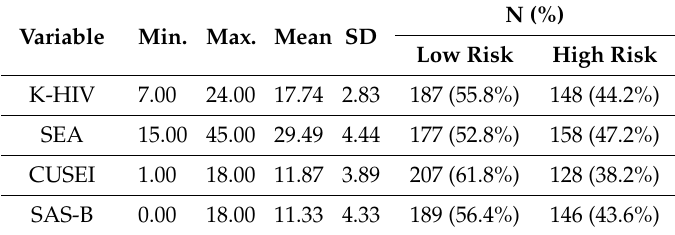
Table 2. Scores in dimensions of risk of HIV infection in the total